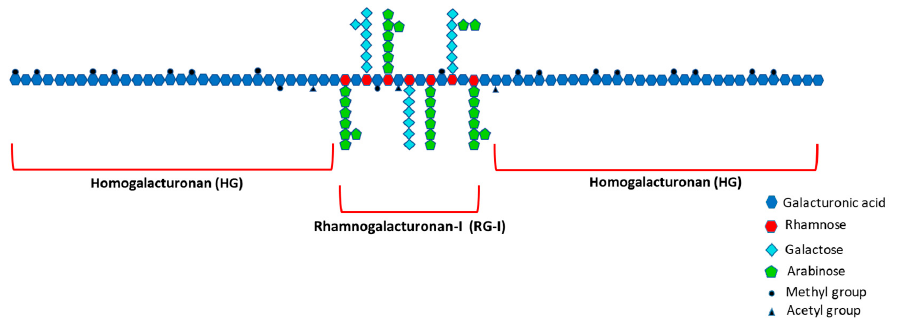
Figure 3. Schematic representation of the main pectin domains to aid interpretation of results below. Pectin molecules are high-molecular-weight polysaccharides consisting of a backbone of two main covalently linked repeating structural units: the smooth homogalacturonan (HG) subunit and the highly branched (‘hairy’) rhamnogalacturonan-I (RG-I) subunit. The HG subunits make up 65% of the pectin molecule and the RG-I subunits constitute approximately 20% to 35% [36,37]. The HG regions consist of α -1,4-linked D-galacturonic acid monomers, whereas the RG-I domains have a backbone of the repeating disaccharide [- α -1,4-D-galacturonic acid- α -1,2-L-rhamnose-] [38]. Depending on the plant species, the rhamnose residues in the RG-I backbone are substituted with β -1,4-D-galactan, branched arabinan α -1,5-linked L-arabinofuranose units with additional L-arabinofuranose side-chains or arabinogalactans [39]. Two minor pectin structural elements xylogalacturonan and rhamnogalacturonan-II are not indicated in this